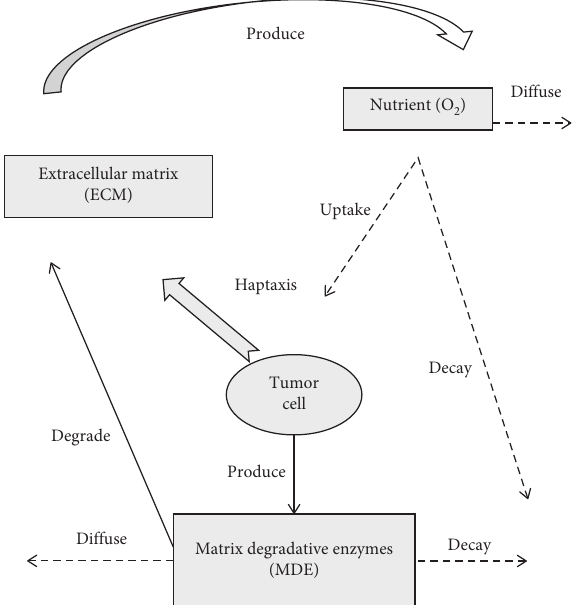
Figure 1: Interactions between the main components in the